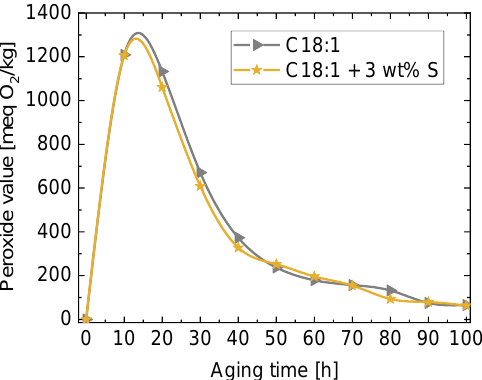
Figure 8. Determination of second measurement peroxide values over time (0–100 h) according to wheeler. The silver line describes the pure C18:1 and the yellow line the C18:1 + 3 wt% S.